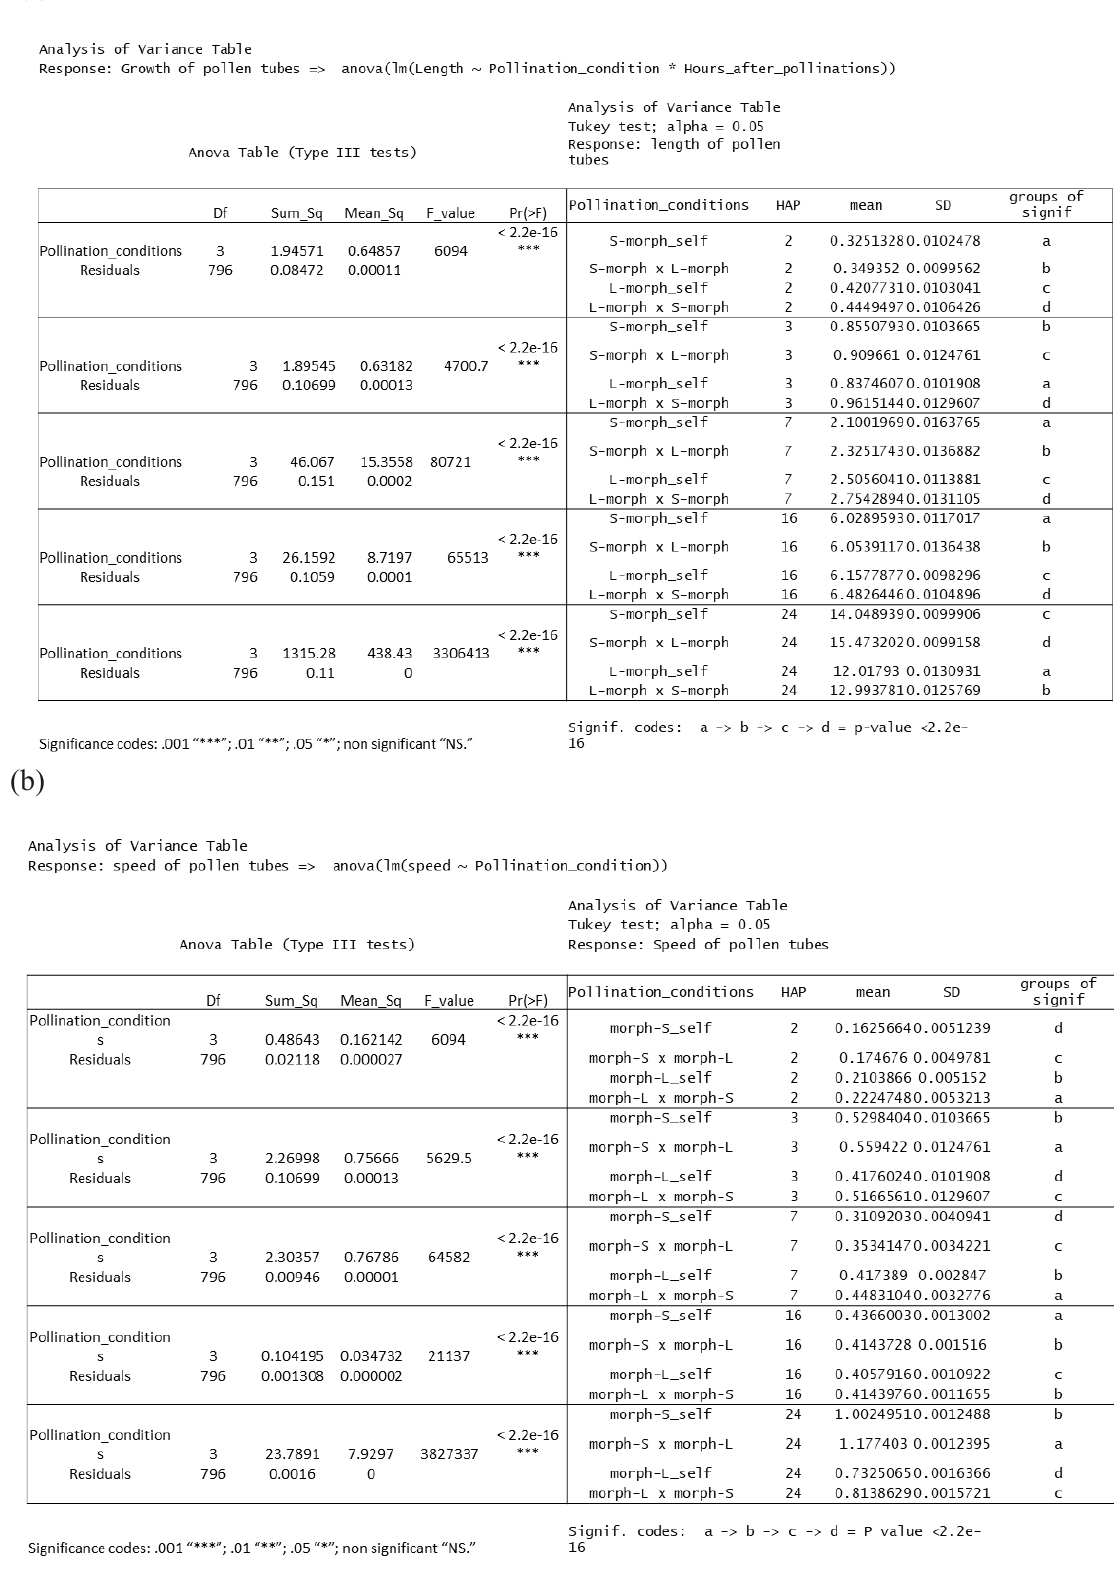
Table S2: Analyses of the variations of pollen tube elongation along time (a), speed (b) and acceleration of pollen tube elongation (b) in both floral morphs in Ludwigia grandiflora subsp . hexapetala after self- and